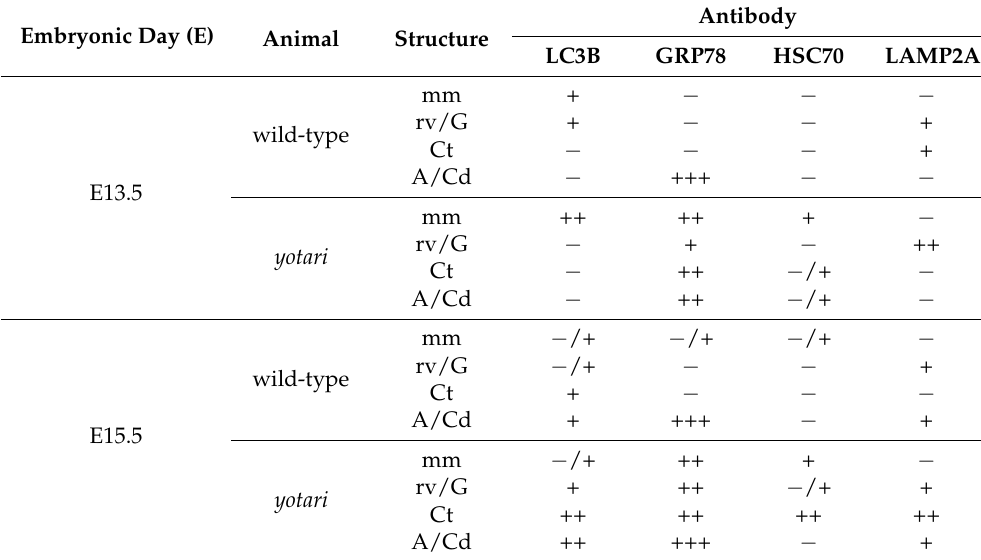
Table 2. Staining intensity of specific antibodies in the kidneys of yotari and wild-type mice at embryonic days E13.5 and